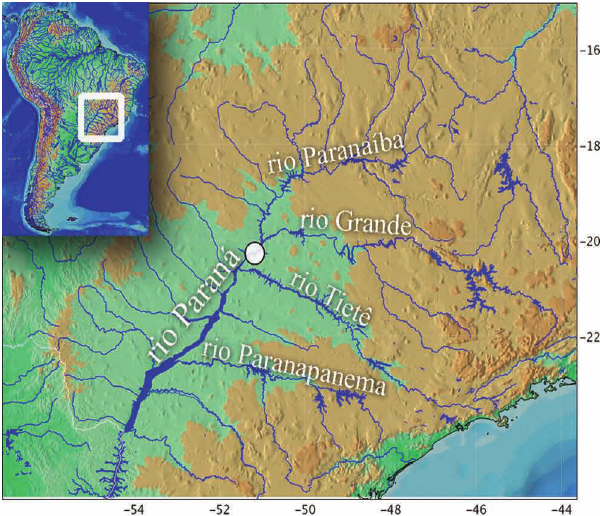
Fig. 7. Map of southeast South America indicating the rio Paraná in UHE Ilha Solteira, type-locality of Centromochlus britskii